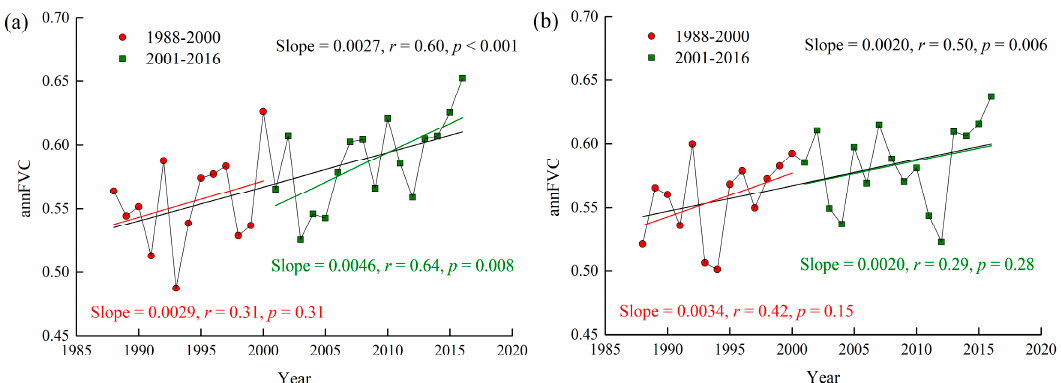
Figure 5. The temporal trends in annual fractional vegetation cover (annFVC) at the watershed level from 1988 to 2016 (full time series) and during 1988–2000 (reference period), and 2001-2016 (conservation period) in: (a) Nandong, and (b) Xiaojiang watershed. Slopes of the trends during these three periods and their corresponding significance levels are shown. The black solid line represents the regression fit to the annFVC data during 1988–2016, while the red and green lines denote the regression fit during 1988–2000 and 2001–2016, respectively.